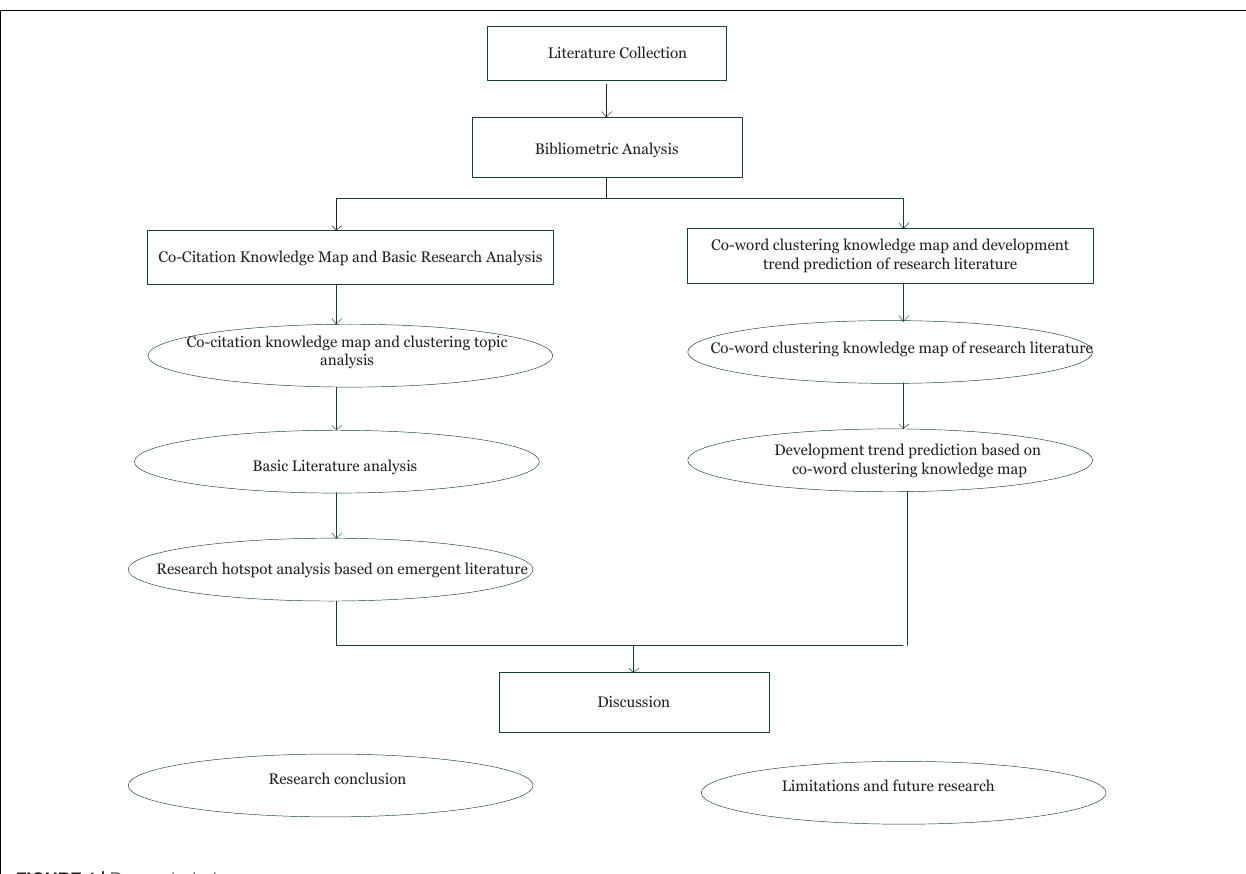
FIGURE 1 | Research